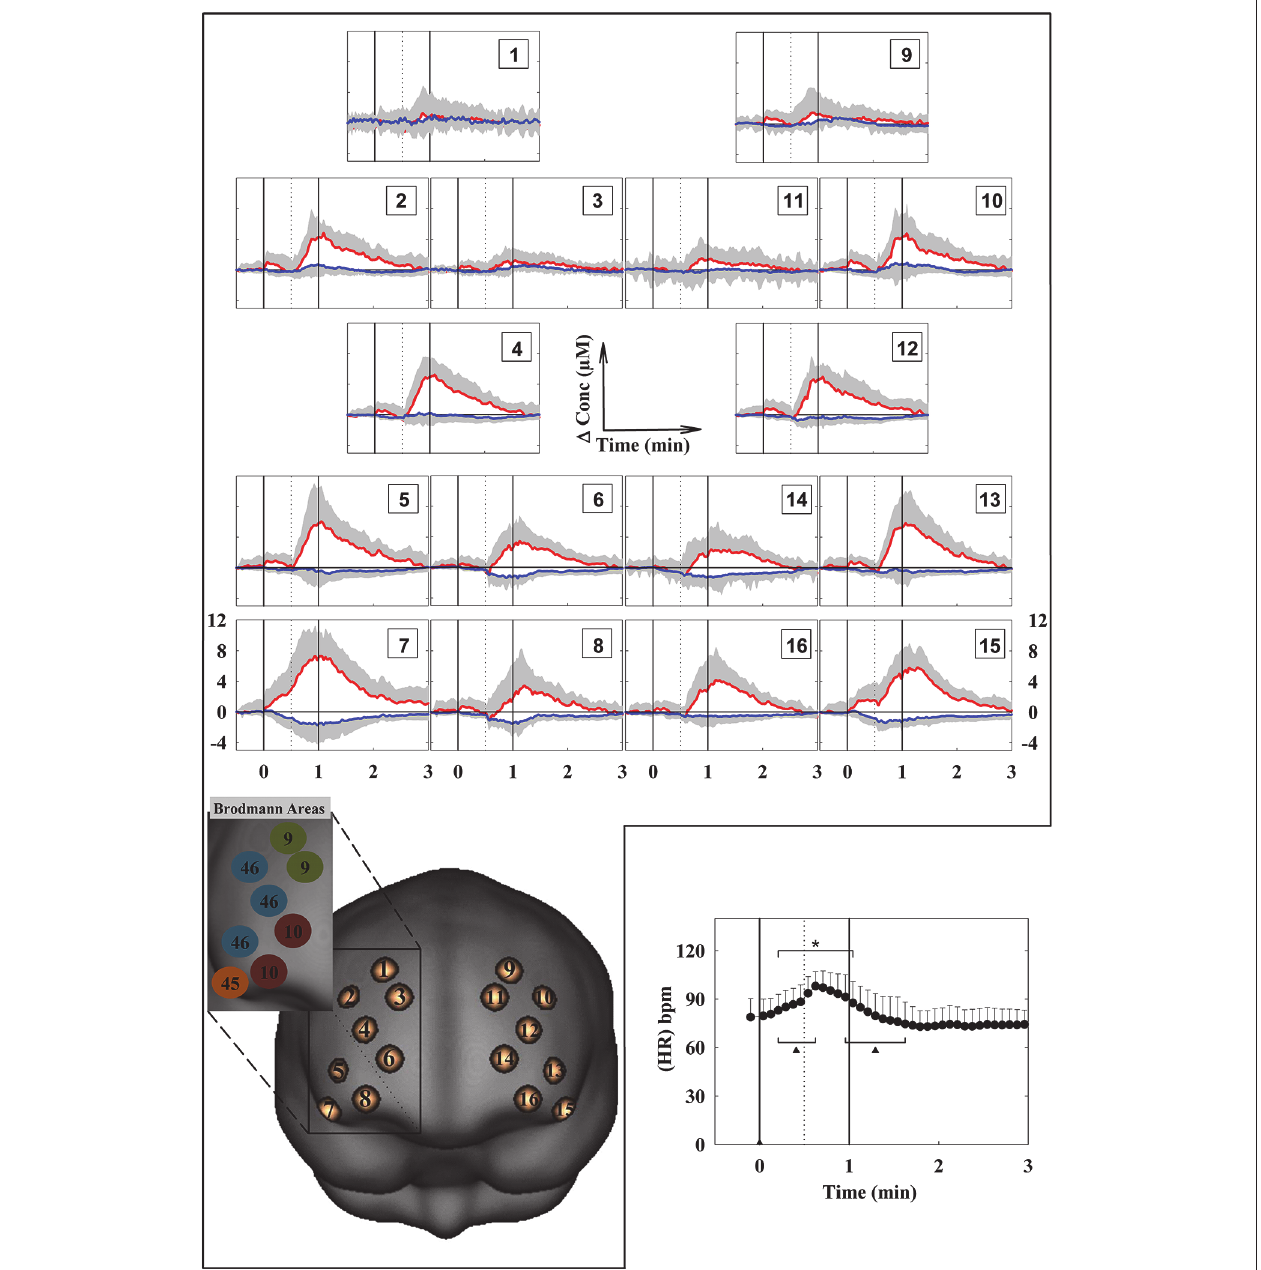
with a 1-cm Gaussian blurring, to reproduce the spatial resolution of fNIRS. The vertical solid lines limit the LMT. The dotted vertical line limits the EP and RP. HR changes were calculated every 5 s. bpm: beats per minute. ( n = 13; mean ± SD). * p < 0.05 with respect to the baseline. (cid:78) p < 0.05 with respect to the previous